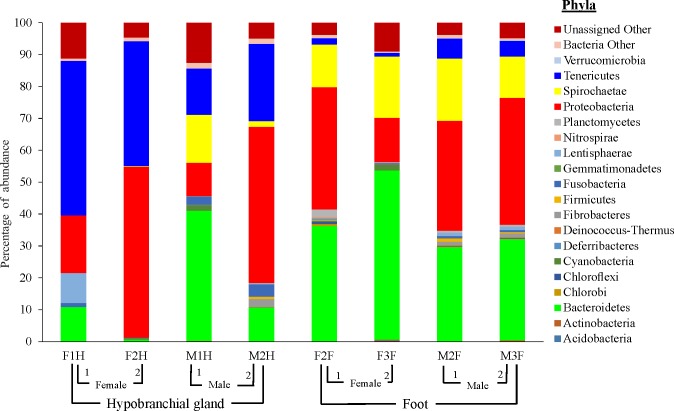
Phylum-level taxonomic diversity associated with the female (F) and male (M) hypobranchial gland (F1H, F2H, M1H and M2H) and foot (F2F, F3F, M2F and M3F) of Dicathais orbita bacterial profiling.All the minor phyla and unnamed, but previously identified bacterial phyla (such as BD1-5, CKC4, candidate division BRC1, OD1, OP8, SR1, TM7, SHA-109, and TM6) are grouped into “Bacteria Other”.